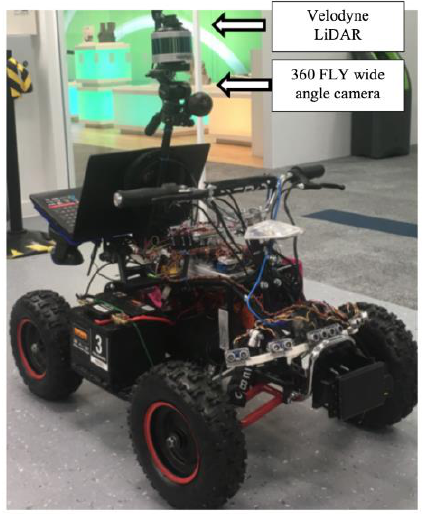
Figure 5. The experimental test bed used for data capture.